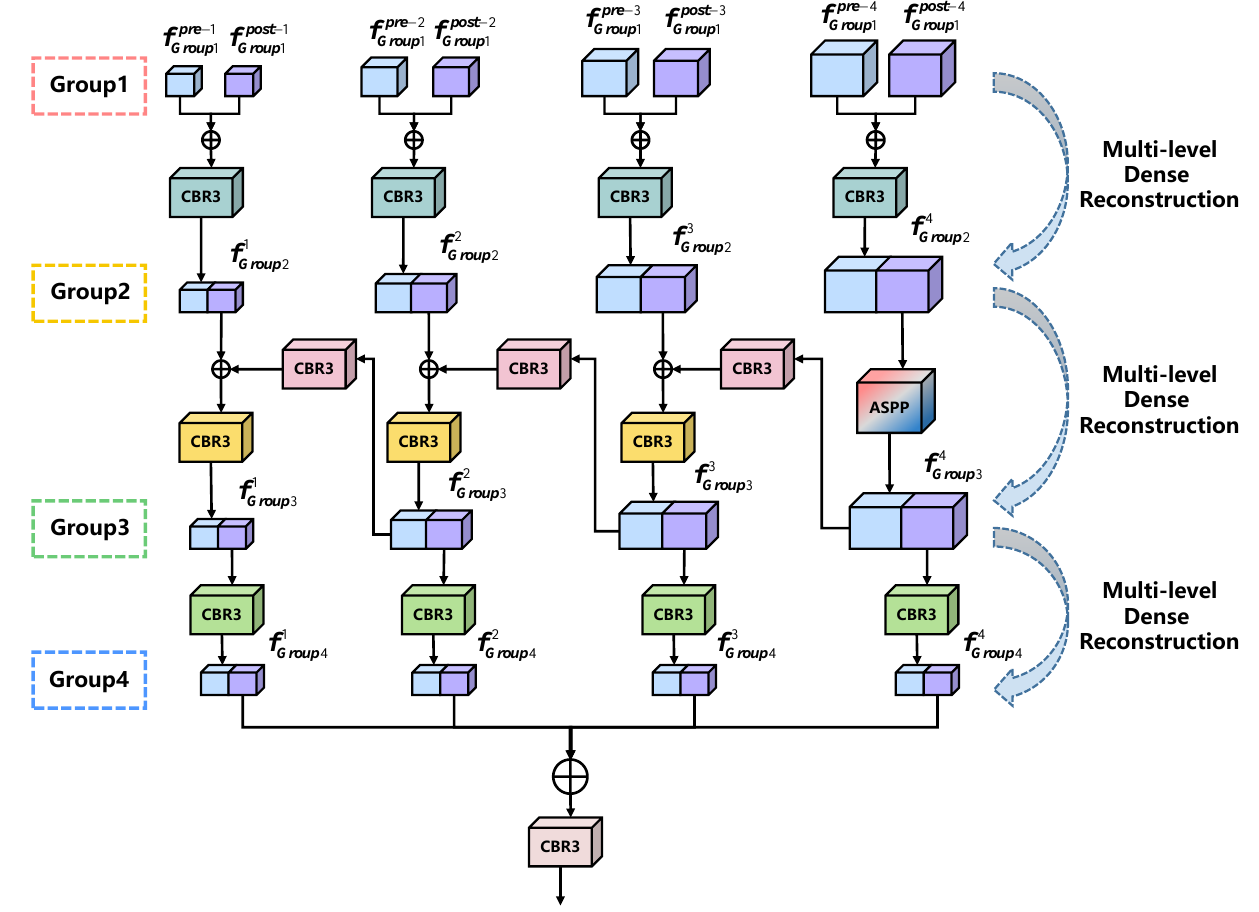
Figure 2. Overview of the multi-path and multi-scale dense reconstruction module.